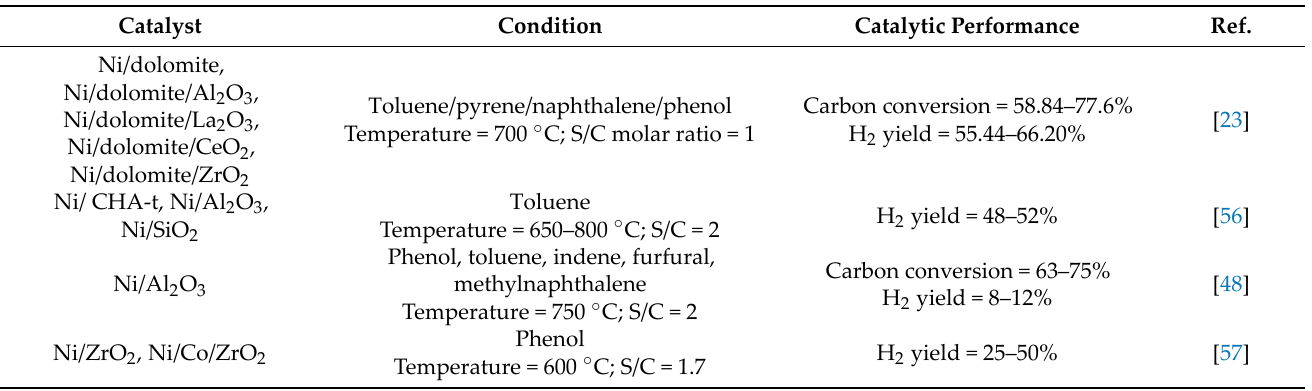
Figure 6. Carbon conversion to gas, H 2 yield, and total gas production from biomass module tar steam reforming over Ni-based catalyst (reaction condition: temperature = 800 °C; S/C ratio = 1; GHSV = 13,500 h − 1 ) . Table 3. Previous studies of Ni-based catalyst tar steam reforming of biomass and the catalytic performance.